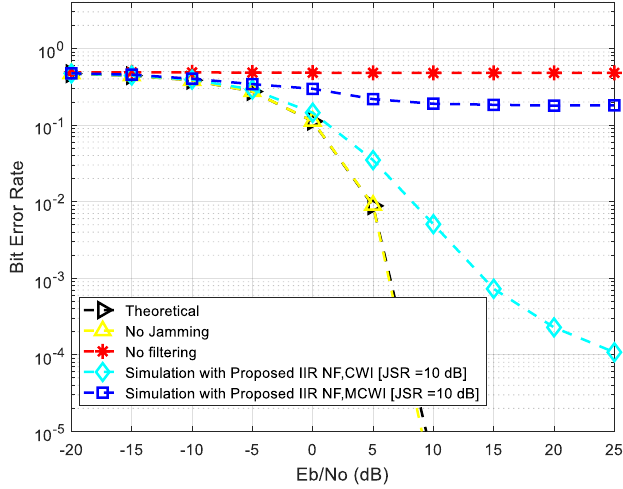
E b 𝐄 𝐛 (in the presence of CWI/MCWI with JSR = 10 dB). (in the presence of CWI/MCWI with JSR = 10 dB). Figure 13. BER vs. N o 𝐍 𝐨